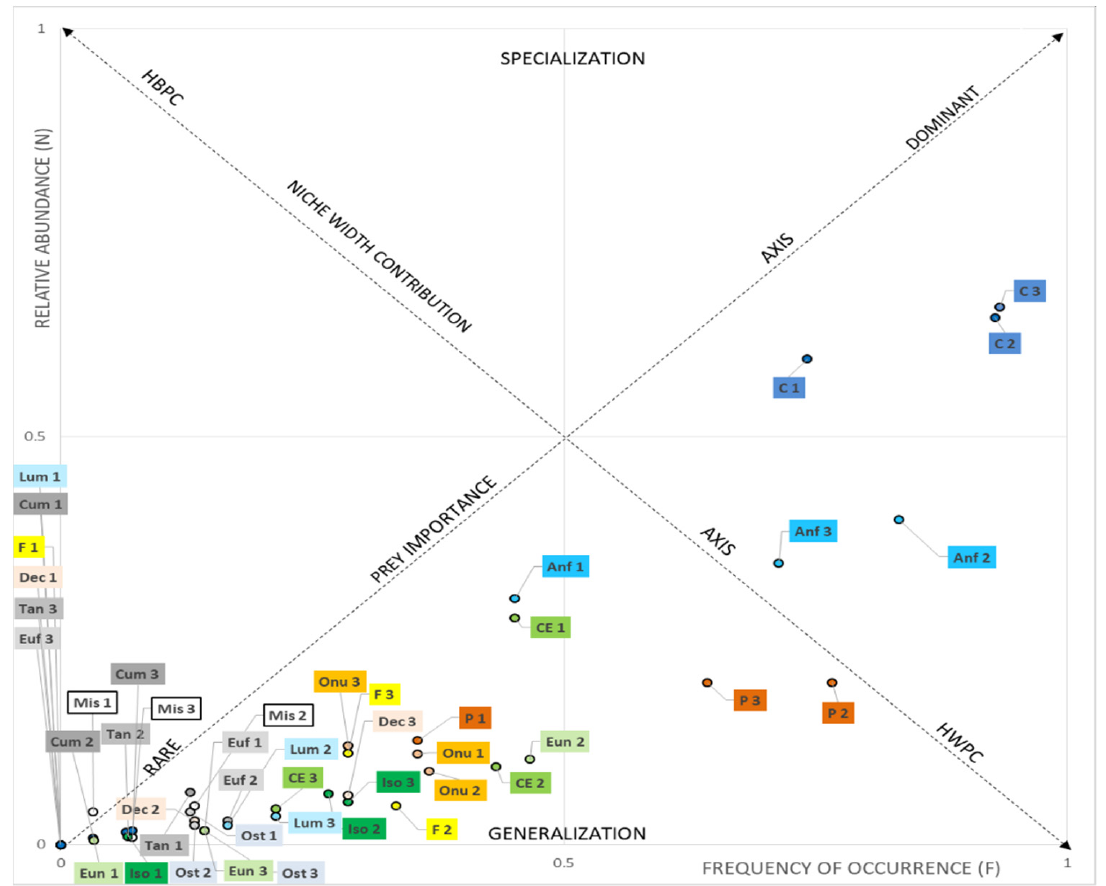
Figure 3. Costello’s diagram representing ontogenetic variation in the diet of Coelorinchus caelorhincus based on prey found at the macro level (F: Fish; C: Crustaceans; P: Polychaetes; CE: Cephalopods) and micro-taxa level (Anf: Amphipods; Iso: Isopods; Mis: Mysids; Dec: Decapods; Tan: Tanaids; Ost: Ostracods; Euf: Euphausids; Cum: Cumaceans; Onu: Onuphids; Eun: Eunicids; Lum: Lumbrinerids) identified in the stomachs of a sample from Central Thyrrhenian sea. The same background color indicates same prey and numbers (1, 2, 3) are for smallest, intermediate, and largest size classes, respectively.